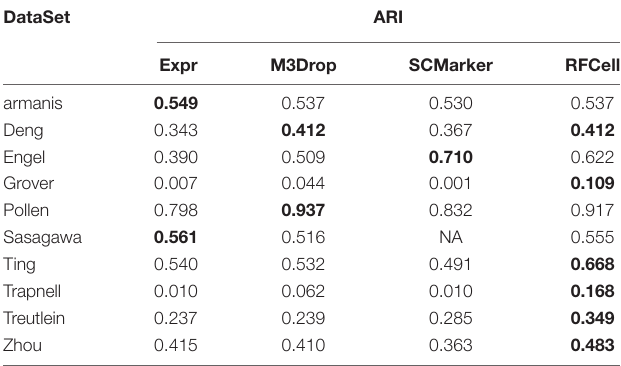
TABLE 3 | Comparison of SIMLR performance of gene sets obtained by four gene selection methods in terms of ARI. DataSet